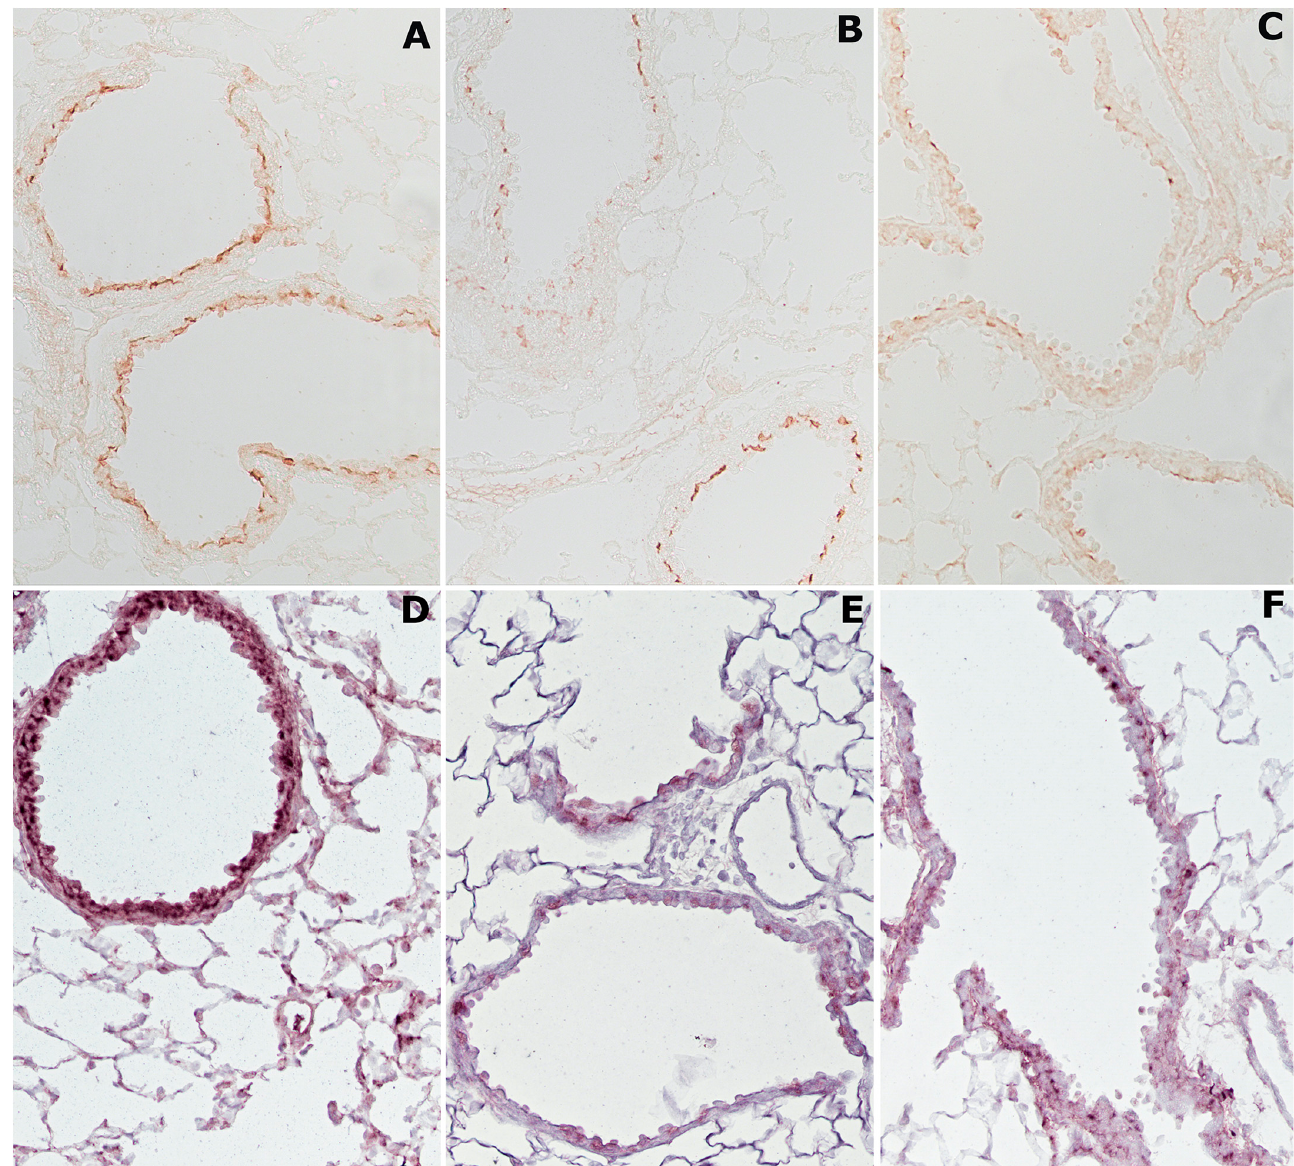
Figure 3. Representative immunohistochemical reaction for histone deacetylases HDAC2 and SIRT1 in mouse lungs from the different experimental groups: ( A ) HDAC2 is usually expressed in lungs from air control mice; ( B ) a marked reduction in the expression of this enzyme is observed in lung tissue of smoking mice at 4 months from the start of the study; ( C ) a similar faint reaction for HDAC2 is observed in lungs from mice left to rest in room air after 4 months of CS exposure; ( D ) SIRT1 enzyme can be seen everywhere on the alveolar epithelium and the airways of air-exposed animals after immunohistochemical staining; ( E ) an appreciable reduction of this enzyme is found in mice at 10 months of CS exposure; ( F ) a weak positivity for SIRT1 is found on sub-bronchial inflammatory cells and peripheral peri-bronchial areas of former-smoker mice. ( A – F ), ×200.